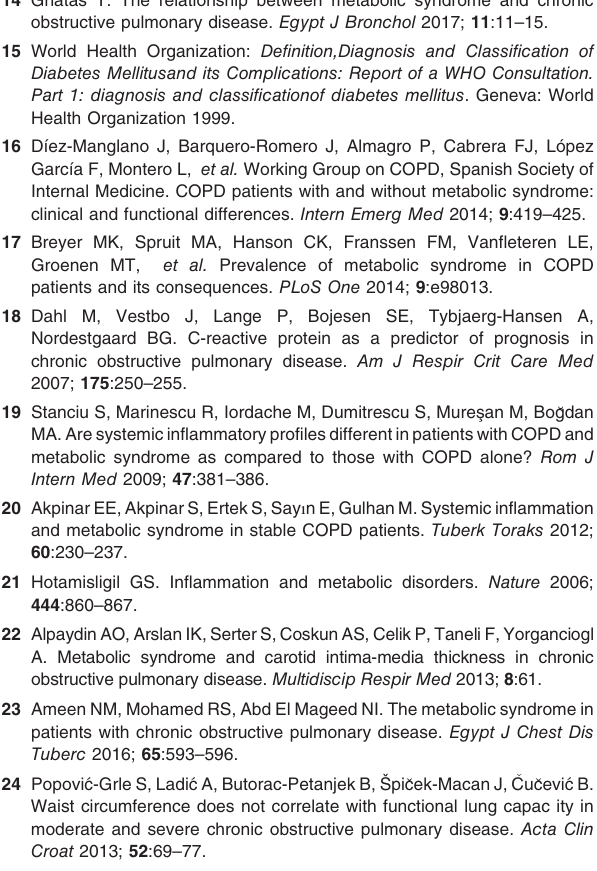
2 National Cholesterol Education Program (NCEP) Expert Panel on Detection, Evaluation, and Treatment of High Blood Cholesterol in Adults (Adult Treatment Panel III). Third Report of the National Cholesterol Education Program (NCEP) Expert Panel